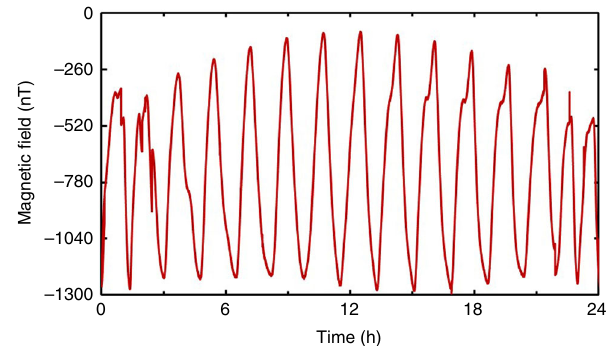
Fig. 6 Magnetic fi eld inside the outer magnetic shield vs time as the spacecraft rotates in LEO. Every peak corresponds to one orbit and the dips shown in some peaks correspond to the magnetic fi eld when spacecraft moves through the South Atlantic Anomaly